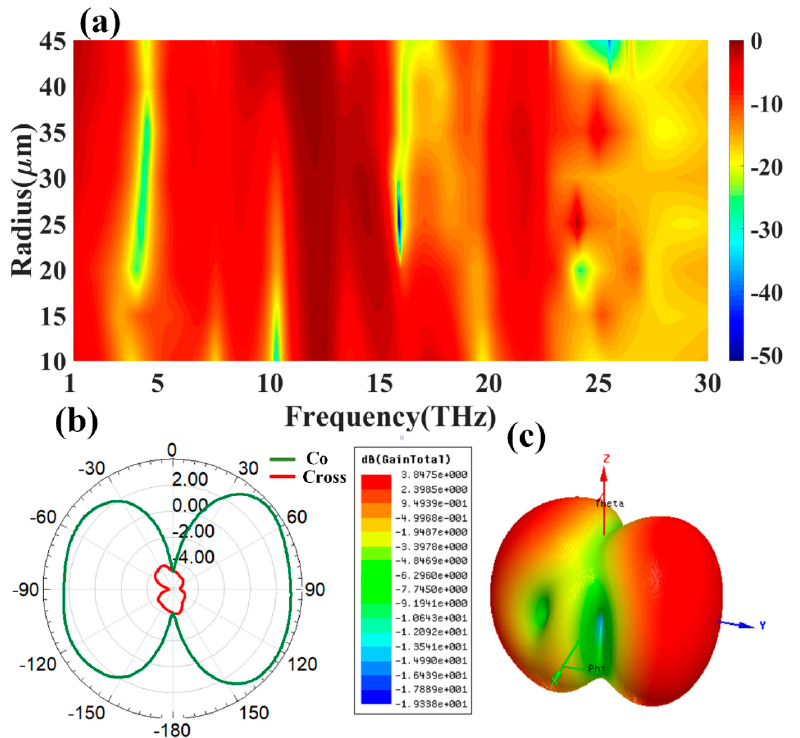
Figure 5. ( a ) Variation in S-parameters (S11) for the different radius values for type-5 antenna. Calculated directivity in ( b ) 2D (with co- and cross-polarization) and ( c ) 3D, by considering a radius of 20 µm.